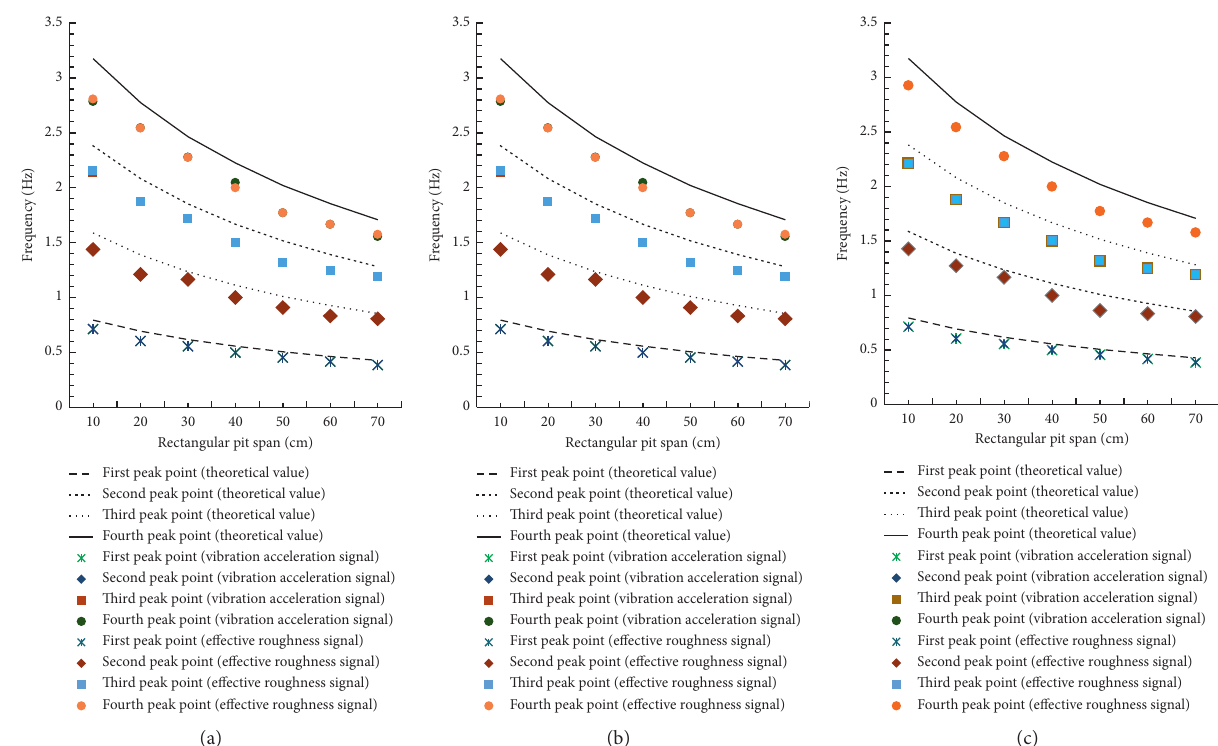
Figure 11: Comparison of the frequency value of original road roughness excitation point, frequency value of effective roughness peak point, and frequency value of vibration peak point. (a) Depth: 10 cm. (b) Depth: 20cm. (c) Depth: 30 cm.